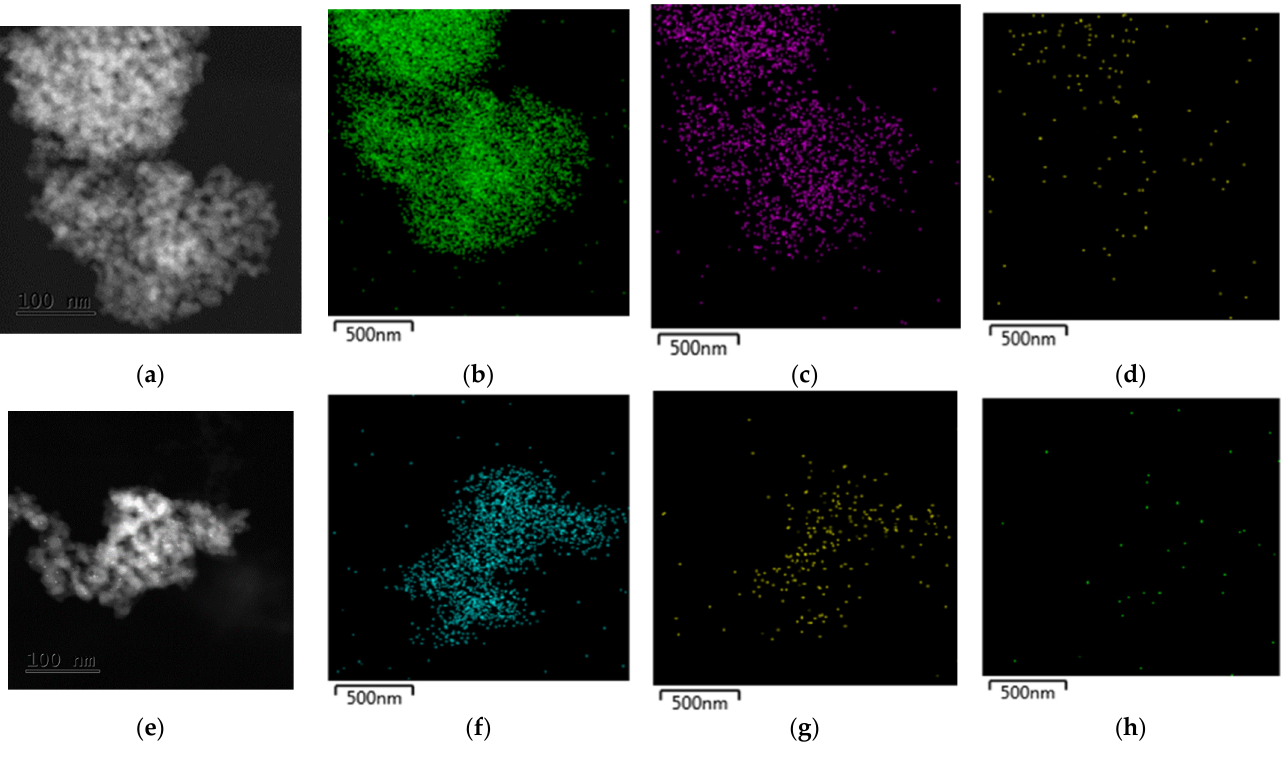
Figure 3. Transmission electron microscopy images of the Pt/TiO 2 -CeO 2 10%: ( a ) Sol-gel to 100 nm scale, ( b ) Sol-gel take α of the Ti, ( c ) Sol-Gel take α of the Ce, ( d ) Sol-Gel take α of the Pt, ( e ) Impregnation to 100 nm scale, ( f ) Impregnation take α of the Ti, ( g ) Impregnation take α of the Ce, and ( h ) Impregnation take α of the